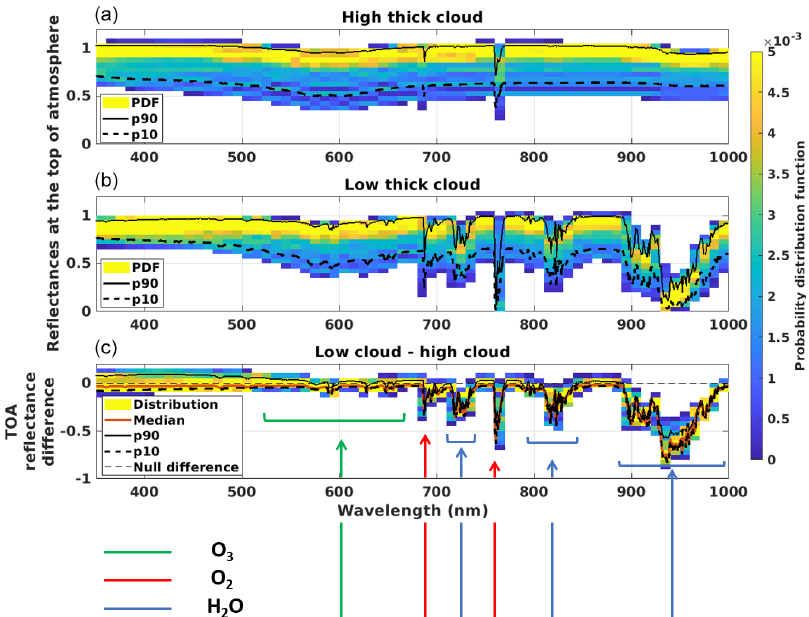
Figure 2. (a, b) Distributions of simulated TOA reflectance spectra in overcast conditions ρ ovc for the different viewing geometries in the look-up table and for a solar zenith angle of 30 ◦ , with a thick liquid cloud (COT = 150). (a) CTH = 15km; cloud base height (CBH) = 2km. (b) CTH = 0 . 5km; CBH = 0 . 2km. (c) Error on ρ ovc caused by a misattribution of cloud height to the “low thick cloud” category. Green, red, and blue arrows indicate spectral regions with main absorption features from O 3 , O 2 , and H 2 O,